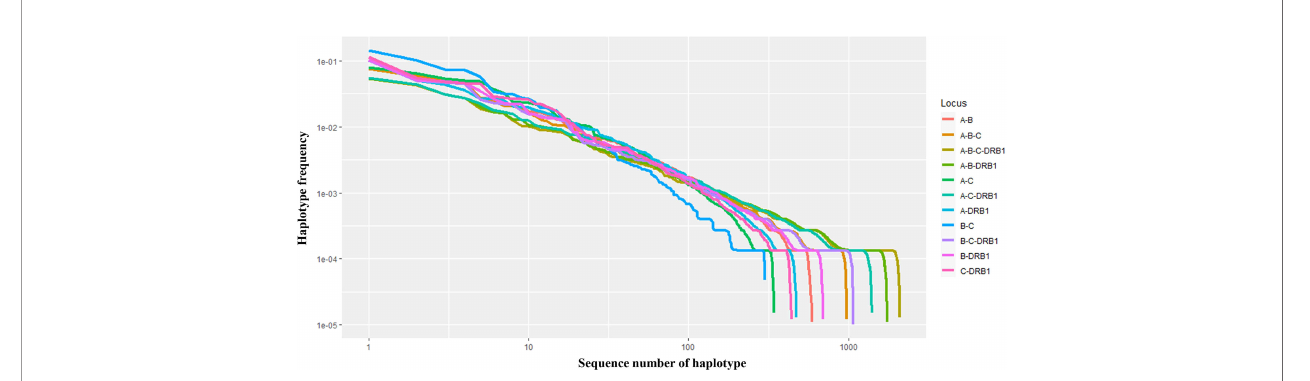
FIGURE 4 | Curves showing the haplotype frequency of each set of loci (A – B, A – C, A – DRB1, B – C, B – DRB1, C – DRB1, A – B – C, A – B – DRB1, A – C – DRB1, B – C – DRB1, A – B – C – DRB1) in descending order. Both the x - and y -axes are expressed on a logarithmic